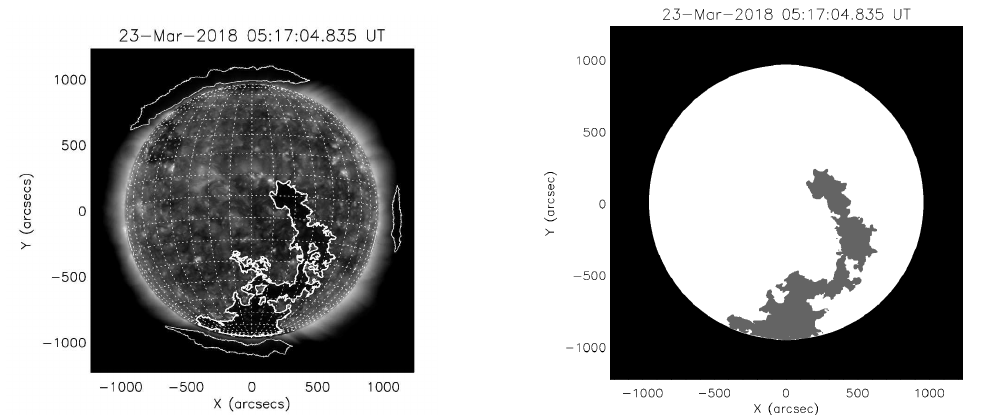
Figure 1. ( Left ) Coronal hole visible on the solar disk obtained by the CHIMERA method. ( Right ) The same coronal hole obtained by the RGA method.